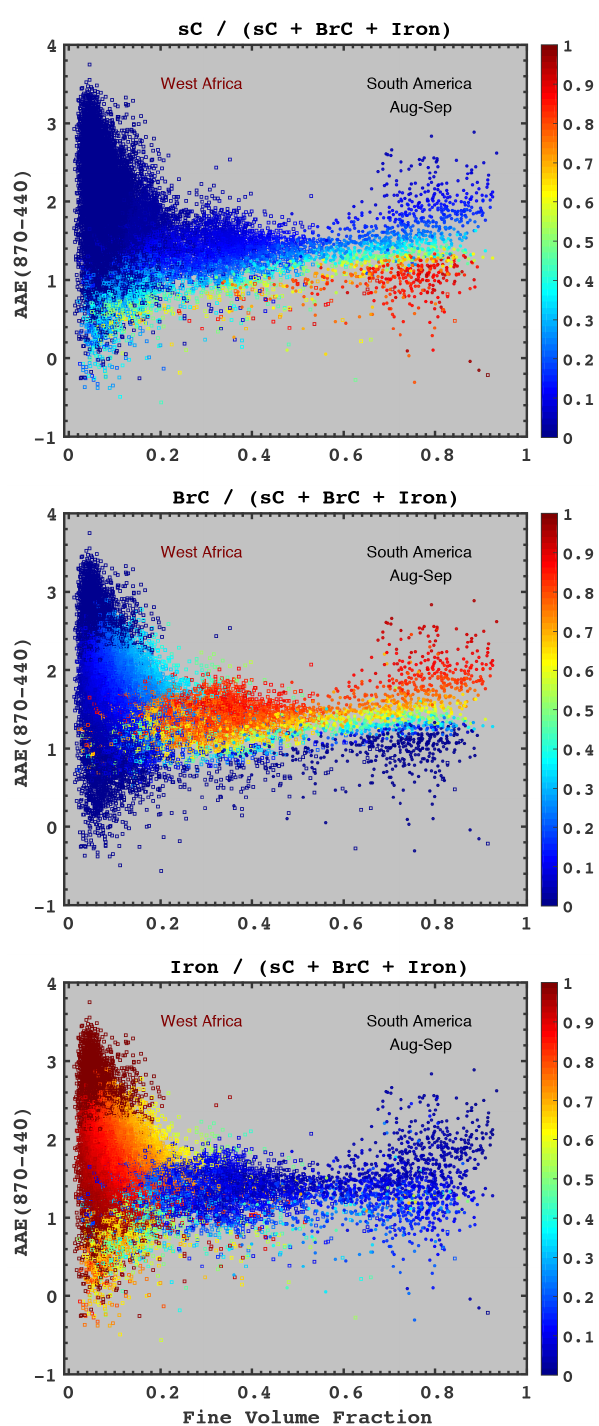
Figure 10. Volume fraction of absorbing species associated with each absorber, as a function of AAE and fine volume fraction. Data located mainly on the left are from the West African sites; data on the right correspond to the biomass burning season at the South American